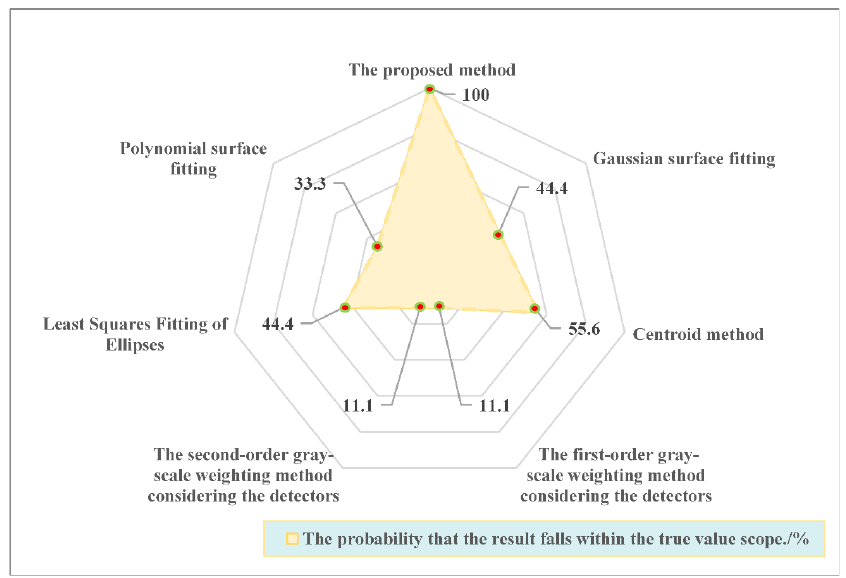
Figure 10. Probability that centroids obtained with different methods fall in the truth value scope.